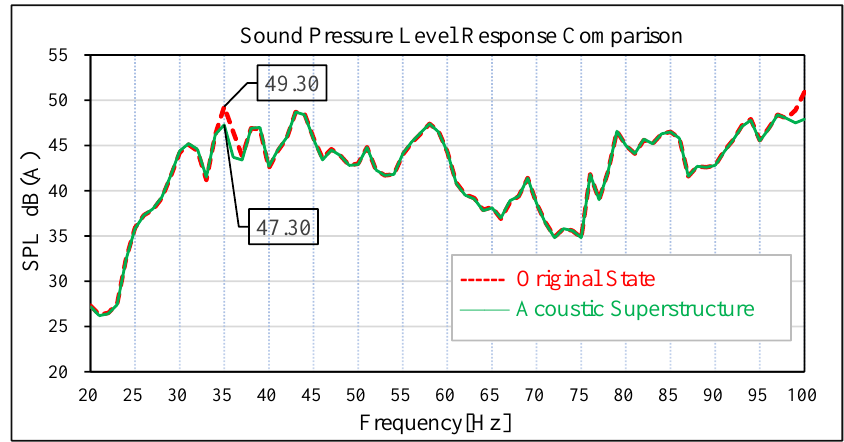
Figure 19. Comparison of sound pressure levels in the driver’s right ear.